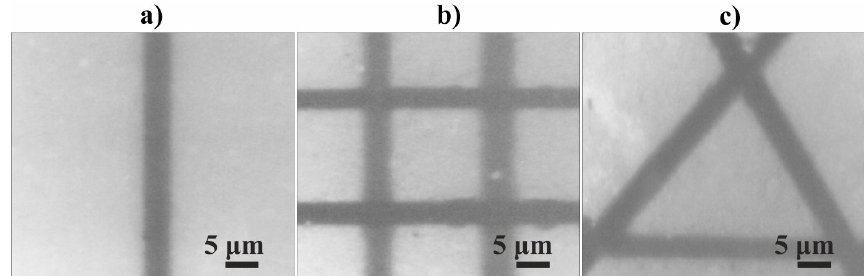
Figure 6. Laser written patterns on the HP-HT nanodiamond film surface: ( a ) line, ( b ) square, and ( c ) triangle under white light illumination.